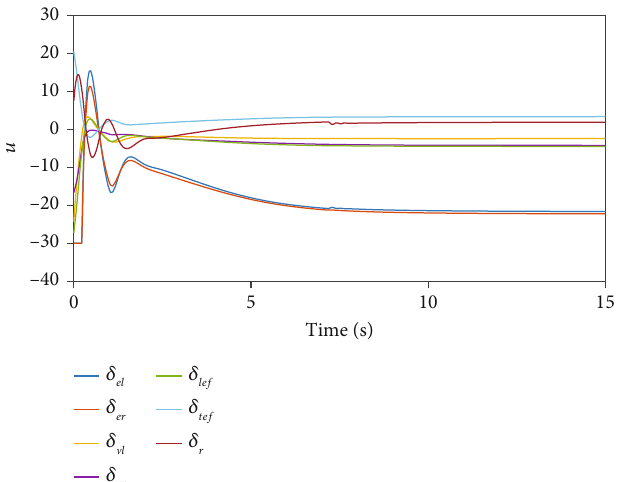
Figure 11: The responses of actuator of fi ghter 2.